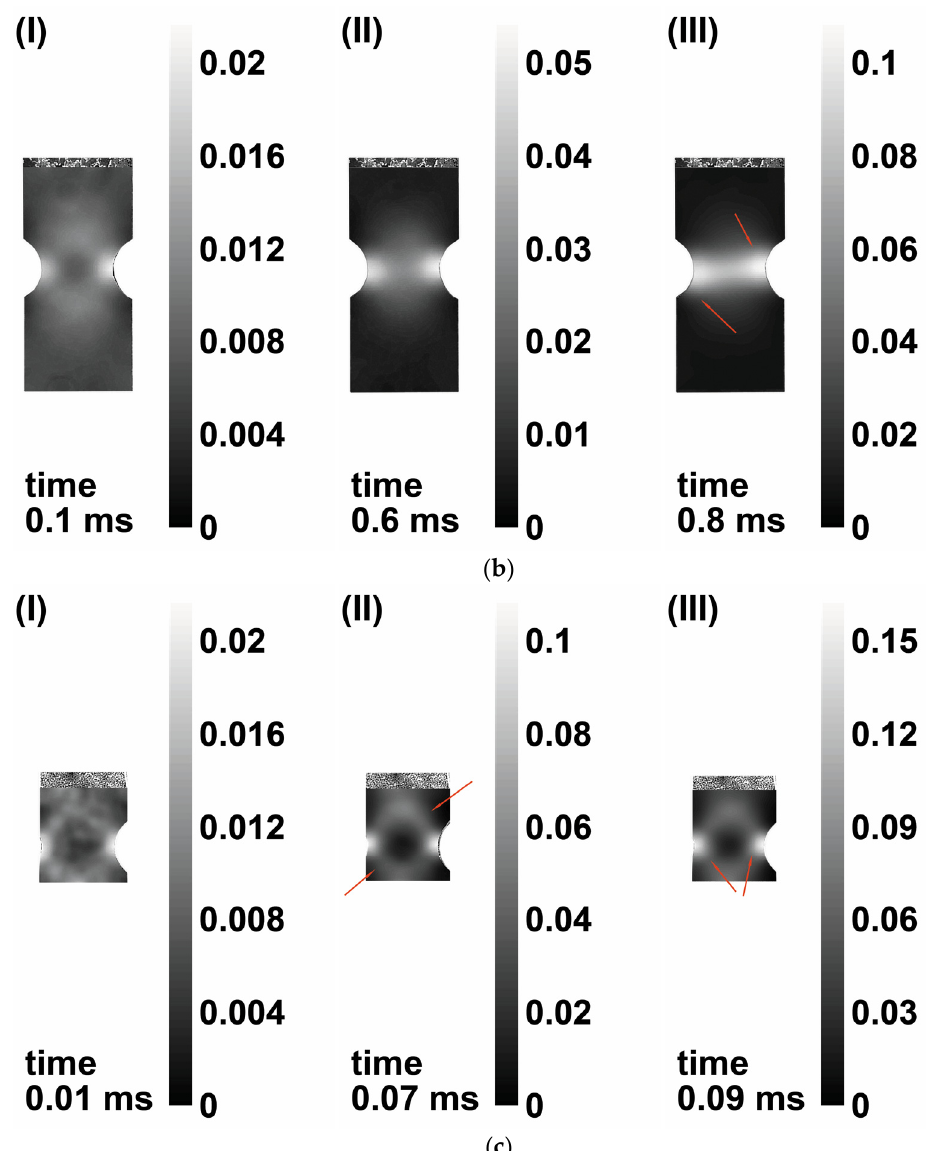
Figure 8. Fields of equivalent strain of specimens with the notch radius of 2.5 mm at ( a ) 0.1 s − 1 , ( b ) 100 s − 1 , and ( c ) 1000 s − 1 .